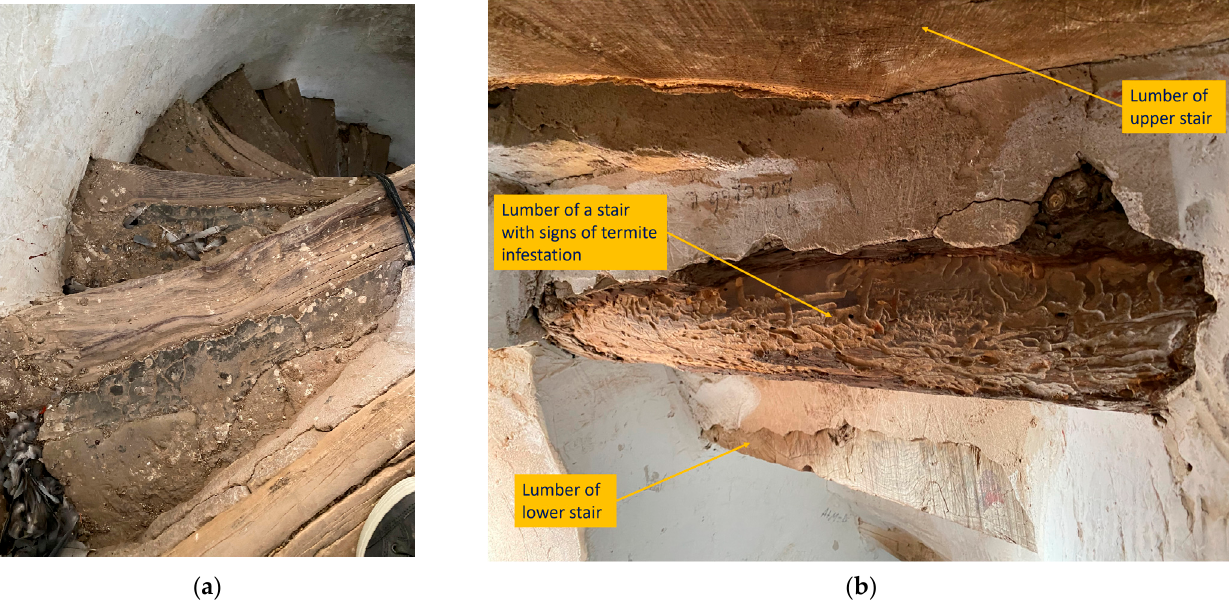
Figure 16. Construction details of the staircase: ( a ) typical view of a stair’s top; ( b ) typical view of a stair’s bottom.